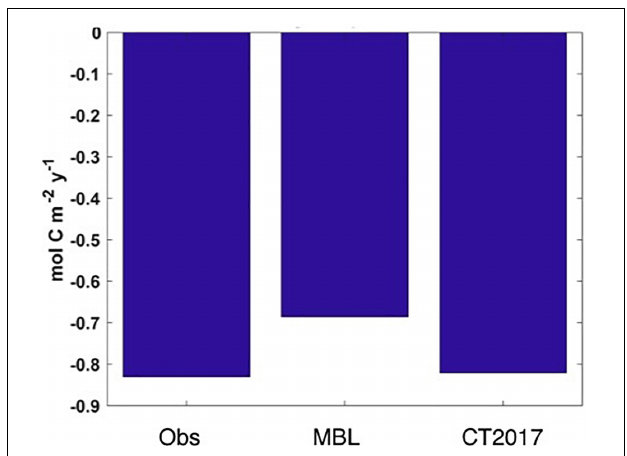
FIGURE 5 | Air-sea CO 2 fluxes at Martha’s Vineyard, calculated using three different sources of atmospheric CO 2 : in situ observations at the site (obs); the NOAA MBL reference product (MBL) and CarbonTracker 2017